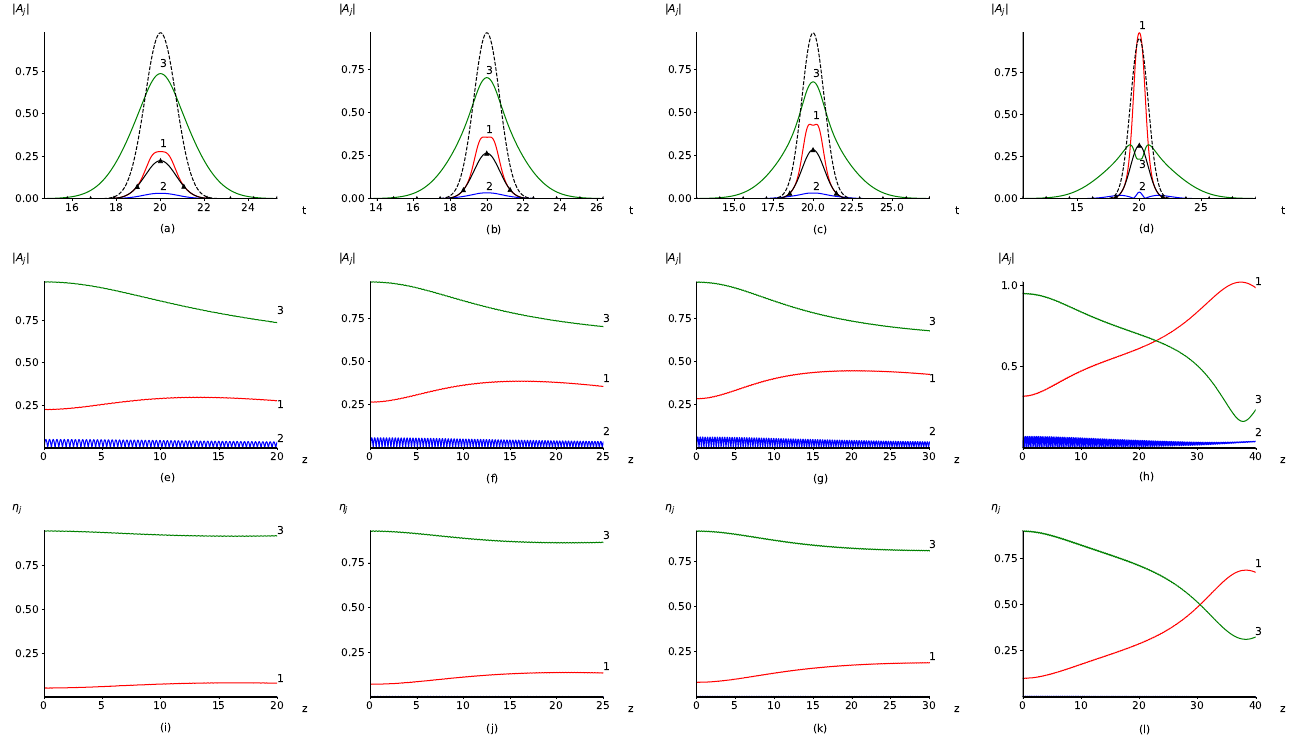
Figure 2. Pulses’ shapes in the sections z = 20 ( a ), 25 ( b ), 30 ( c ), 40 ( d ); pulse intensity evolution at their centers ( e – h ), and the frequency conversion efficiency evolution ( i – l ) along the z -coordinate computed for | A 10 | 2 = 0.05 ( a , e , i ), 0.07 ( b , f , j ), 0.08 ( c , g , k ), 0.1 ( d , h , l